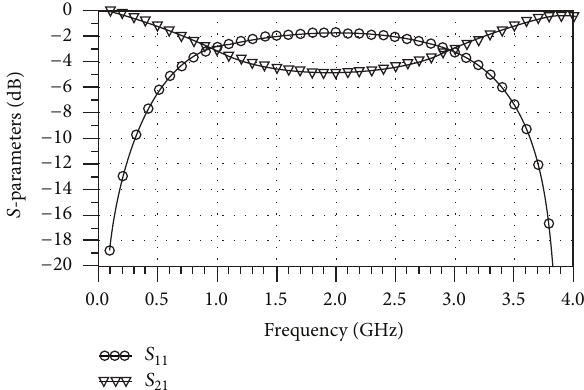
Figure 4: Electromagnetically calculated 𝑆 -parameter of the DGS line shown in Figure 3 ( W 1 = 20 mm, W 2 = 5mm, WM = 0.20mm).